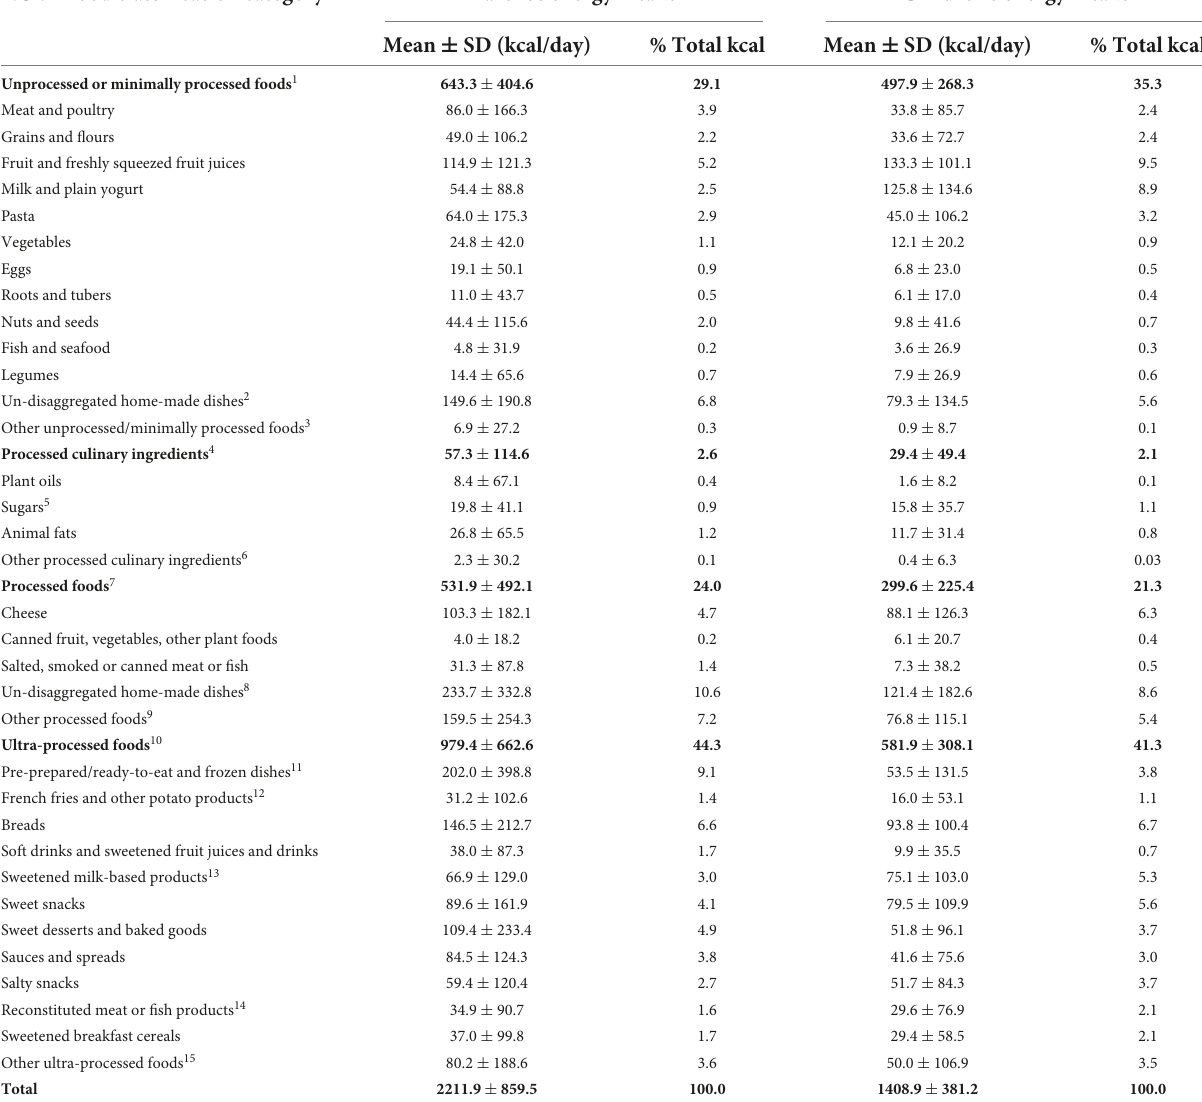
TABLE 2 Distribution of energy intake among NOVA food classification categories among participants in the Guelph Family Health Study ( n = 365 parents and n = 267 children from 242 families). NOVA food classification category Parent’s energy